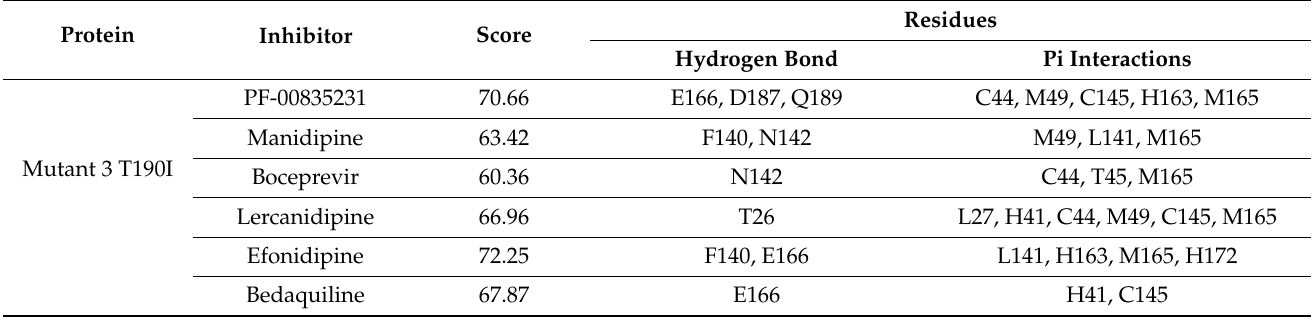
Table 4. The binding details of all compounds against the Mutant 3 (T190I)